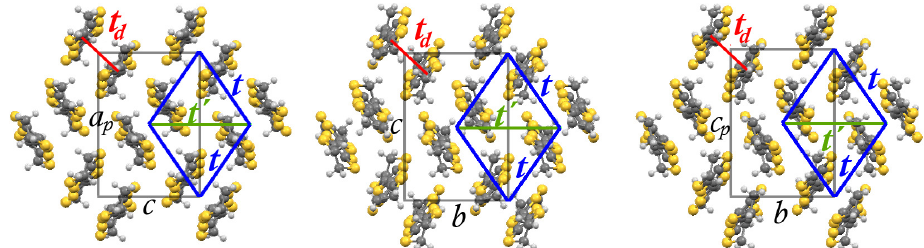
Figure 2. View of BEDT-TTF dimers arranged in anisotropic triangles in the three layered organic charge-transfer salts: ( Left ) κ -Cl, projection of one of the layers is shown along the [110] direction; ( Middle ) κ -CuCN, projected along the [100] direction; and ( Right ) κ -AgCN, projected along the [10-1] direction. Neighboring dimers are rotated by 90 ◦ with respect to each other. The interdimer transfer integrals are denoted by t and t (cid:48) , and the intradimer transfer integral by t d . The ratio t (cid:48) / t measures the degree of frustration. t (cid:48) / t ≈ 0.5 indicates medium frustration for κ -Cl, while t (cid:48) / t ≈ 0.85 indicates high frustration for κ -CuCN and κ